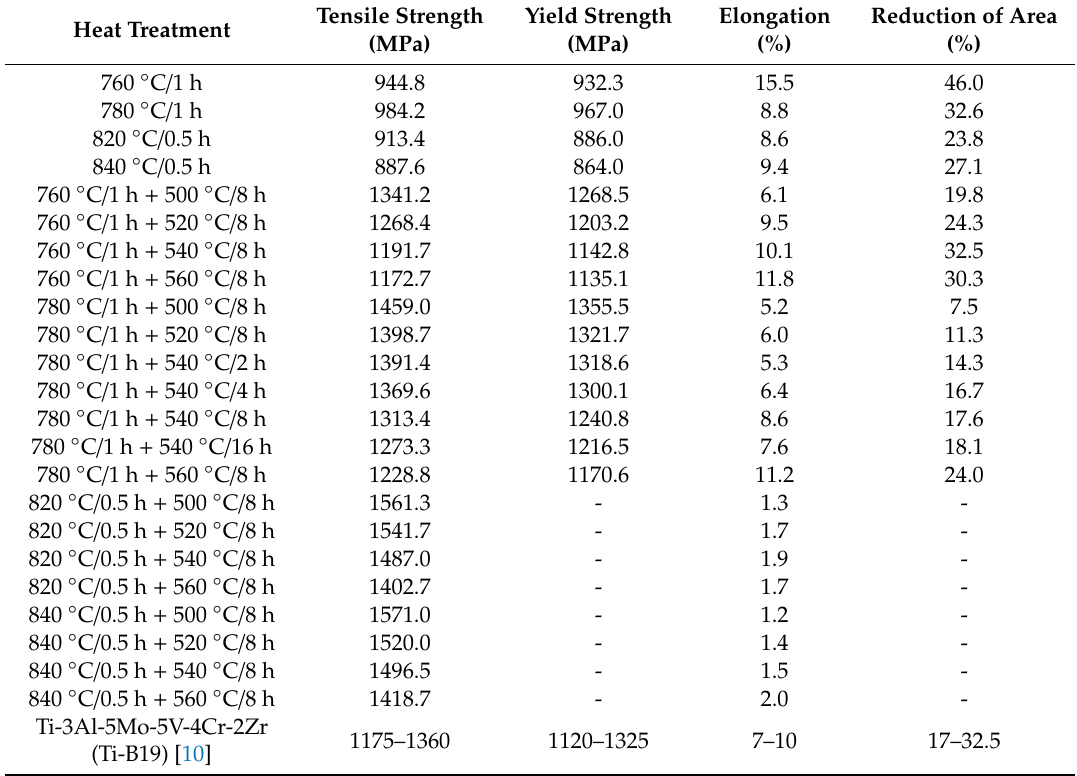
Table 2. Strength–toughness trades of Ti-3Al-5Mo-1Fe -4Cr-2Zr